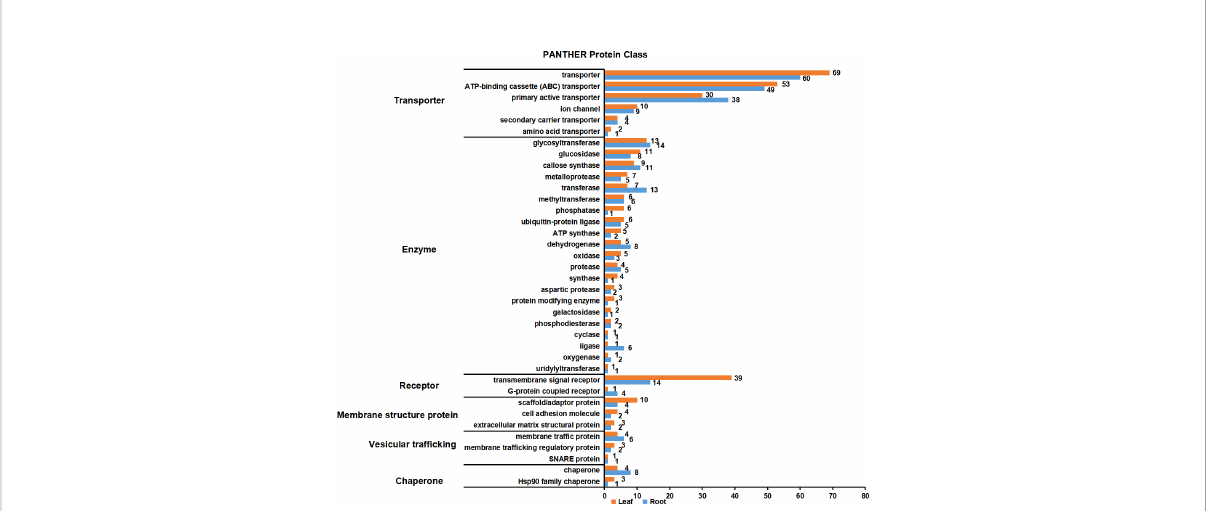
FIGURE 6 Functional classi fi cation of PM proteins in leaves and roots. The function of PM proteins are classi fi ed according to PANTHER classi fi cation system. The PM proteins were divided into six major categories: transporter, enzyme, receptor, membrane structure protein, vesicular traf fi cking and chaperone. Orange and blue blocks indicate the number of PM proteins in leaves and roots,